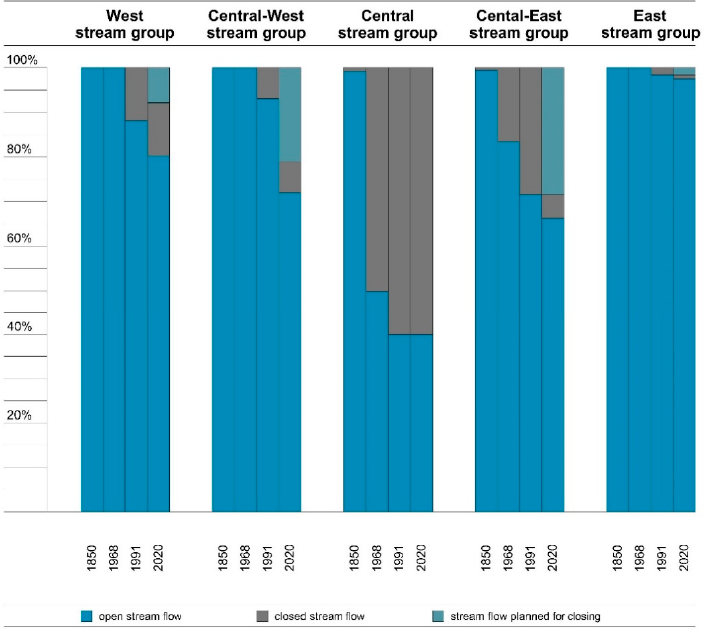
Figure 3. The ratio of open, closed, and stream flows planned for the closing of five spatial areas, in 1850, 1968, 1991, and 2020. Source: Authors.